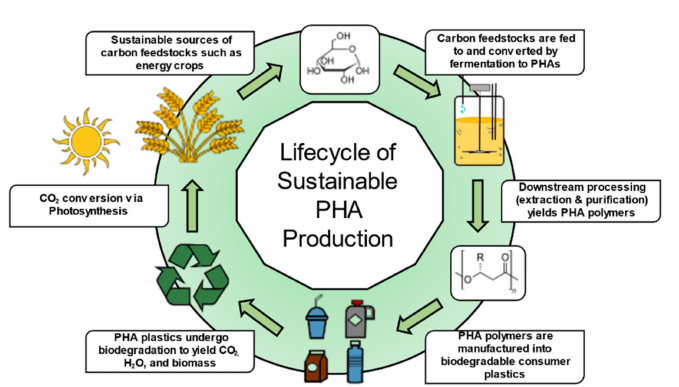
Figure 3. Using renewable, low-cost carbon sources such as energy crops or waste streams in combi- nation with optimized fermentation strategies supports high yielding PHA production processes. The PHA polymers are processed and manufactured into consumer plastics that will biodegrade when disposed. The cycle begins again when biodegradation products of PHA plastics are consumed during photosynthesis or are recovered in waste streams from composting facilities.